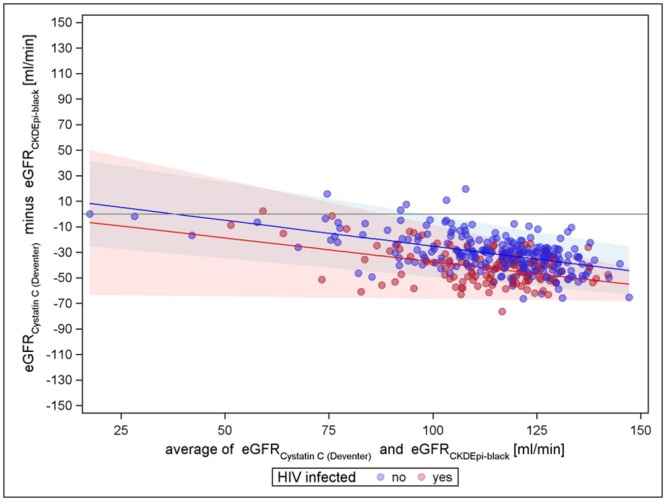
Cystatin C (van Deventer) versus MDRD4 with factor for black Americans.